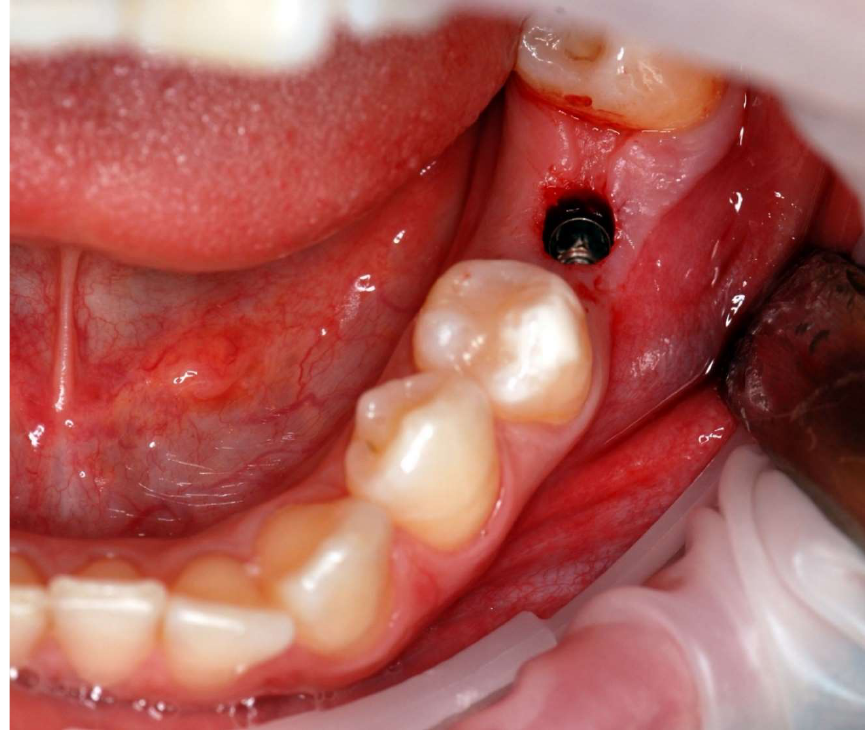
Figure 3. Tissue status immediately after implantation in the flapless technique—no need for wound suturing.